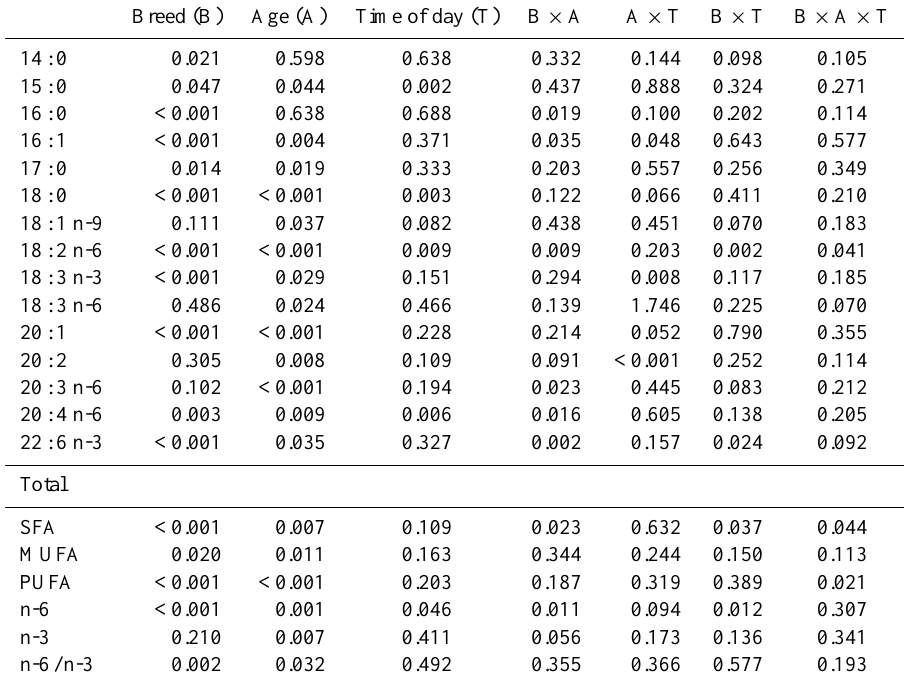
Table 5. t test and analysis of variance of the effect of breed, age and time of day on fatty acid composition of whole eggs ( P values of independent variables and interactions).